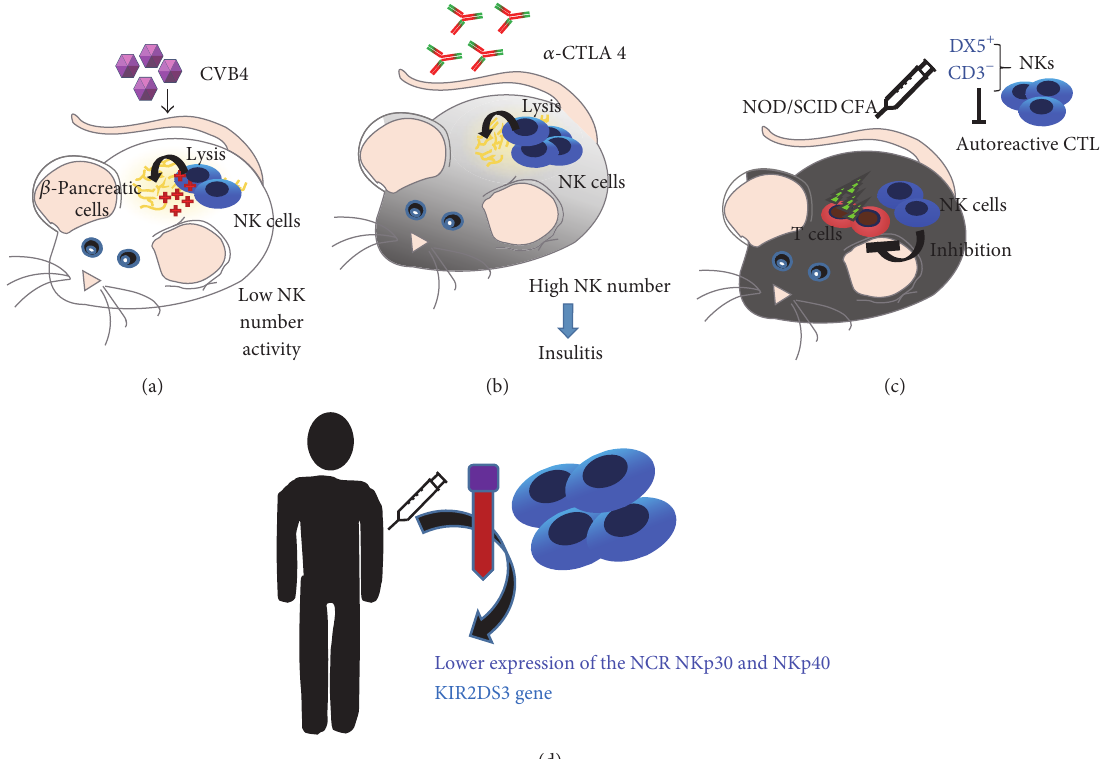
Figure 3: Natural killer cells in type1 diabetes. Several in vivo studies correlate NK cells to diabetes progression: an in vivo model of coxsackievirus B4- (CVB4-) induced diabetes showed that NK antiviral defence resulted in a reduced permissiveness to infection and subsequent NK cell-dependent death (a). Anti-CTLA-4 mAb treatment of T cell receptor transgenic mice demonstrated that higher frequency of NK cells induces aggressive insulitis, resulting in b-islet cell destruction (b). A protective role of NK cells was reported in NOD mice undergoing complete Freund’s adjuvant (CFA). NOD/SCID mice immunized with CFA recover its protective effects when CD3 − DX5 + NKs are adoptively transferred into animal recipients, by downregulating autoreactive T cell response (c). In human samples, lower expression of the NKp30 and NKp40 was detected in type 1 diabetic patients as compared with control. Type 1 diabetic patients display an increased frequency of KIR gene haplotypes, including the activating KIR2DS3 gene, with a genetic interaction between the KIR and HLA complexes